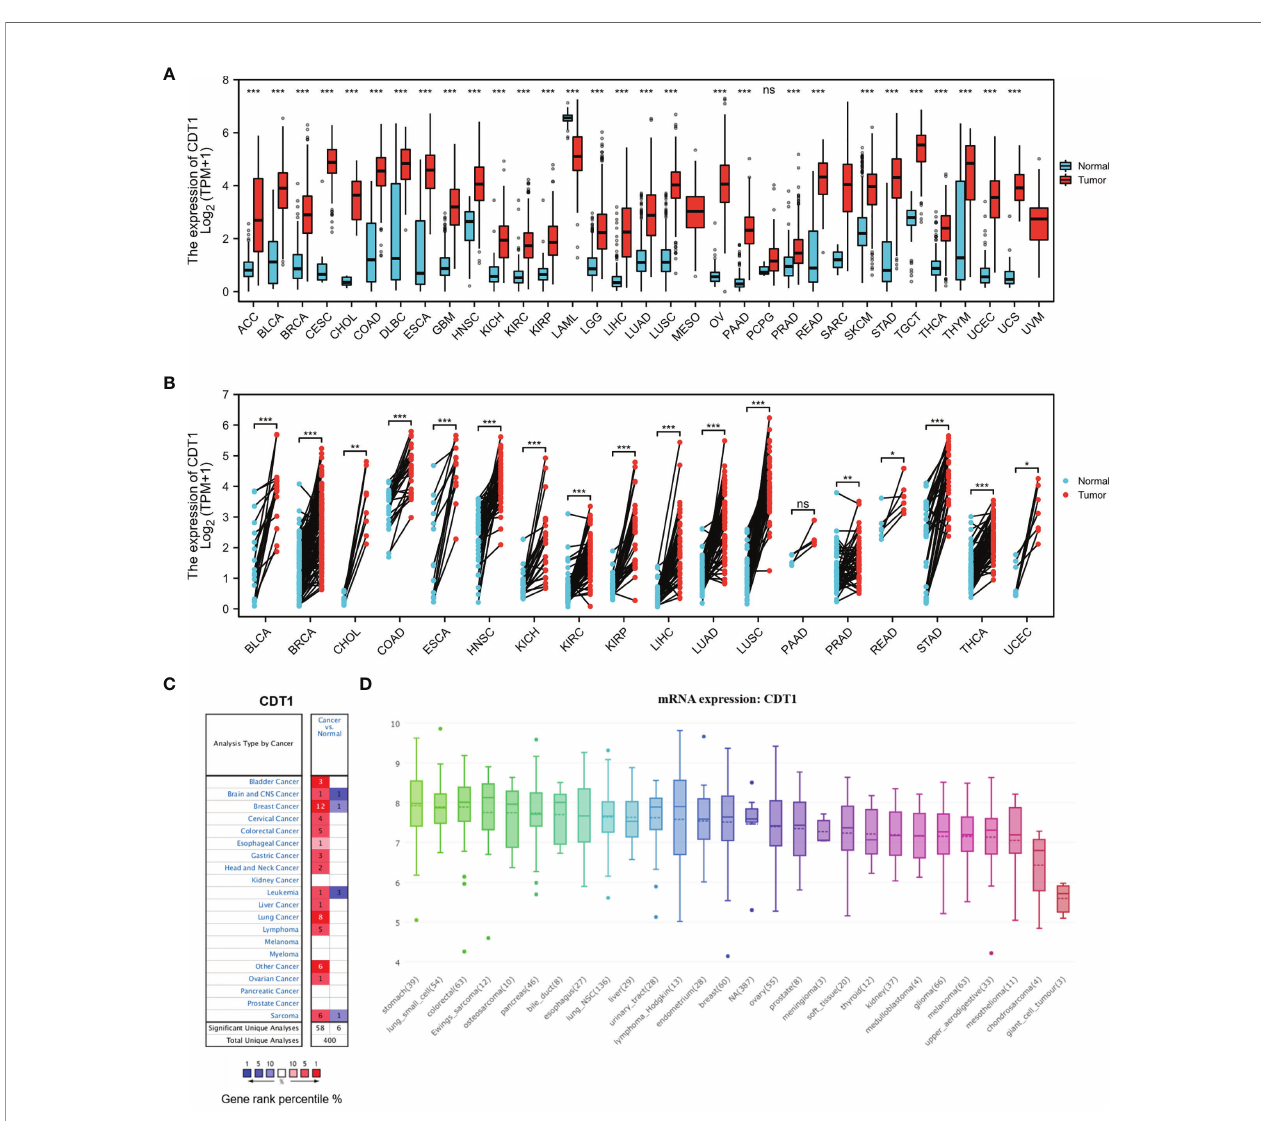
FIGURE 2 | CDT1 expression levels in different types of human cancers. (A) Transcription expression of CDT1 in 33 distinct cancer types (TCGA and GTEx). (B) CDT1 expression in tumor and paired tissues (TCGA and GTEx). (C) Transcription expression of CDT1 in 20 distinct cancer types (ONCOMINE). (D) Expression of CDT1 in various tumor cell lines (CCLE). * p < 0.05, ** p < 0.01, *** p < 0.001. The “ ns ” stands for not signi fi